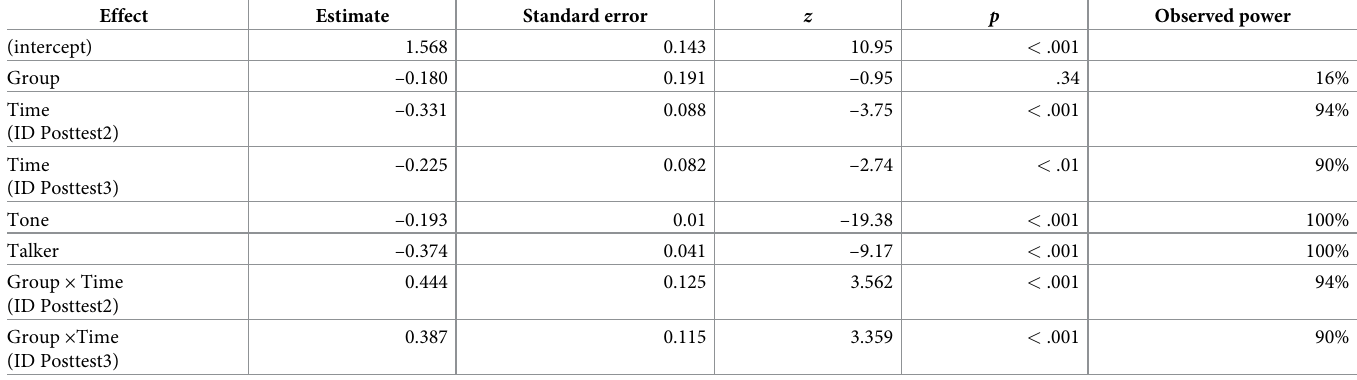
Table 3. Best logit mixed-effects model on proportions of correct response of the participants from the morning and evening groups in the three ID